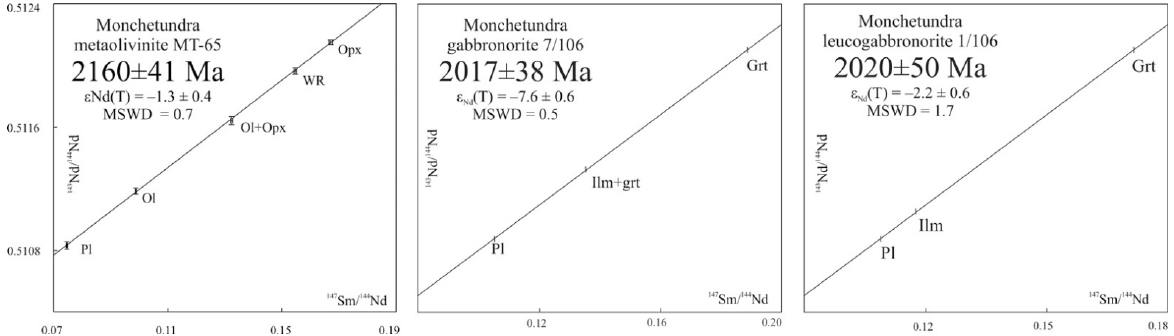
Figure 9. Mineral Sm-Nd isochrones for rocks of the Monchepluton complex.